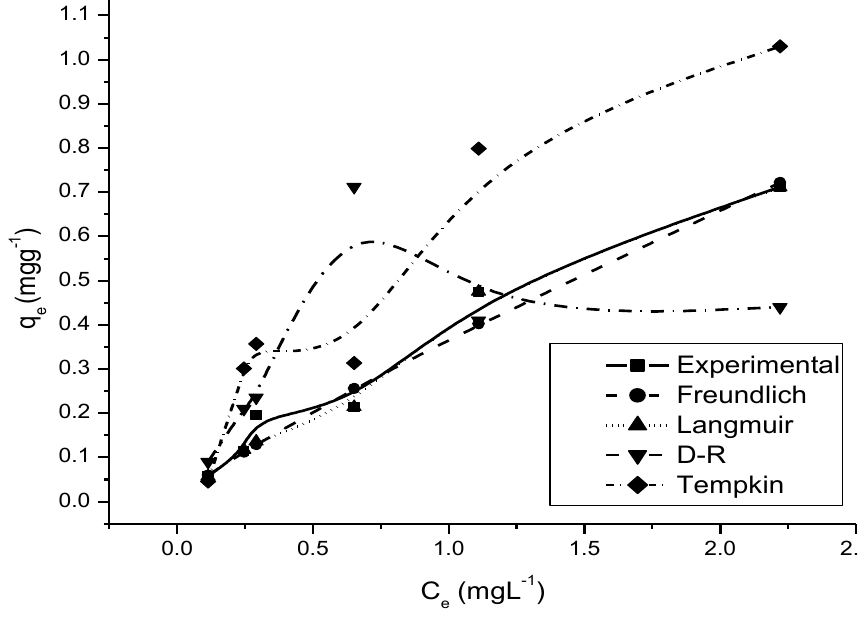
Figure 11. Comparison between the measured and modeled isotherm profiles for the adsorption of fluoride by using eggshell powder on different initial concentration (mg -1 L): (experimental condition pH of the solution: 6.0, adsorbent dose: 2.4 g/100 ml, particle size: 150  m, agitation speed: 350 rpm, Contact time: 100 minutes, Temperature: